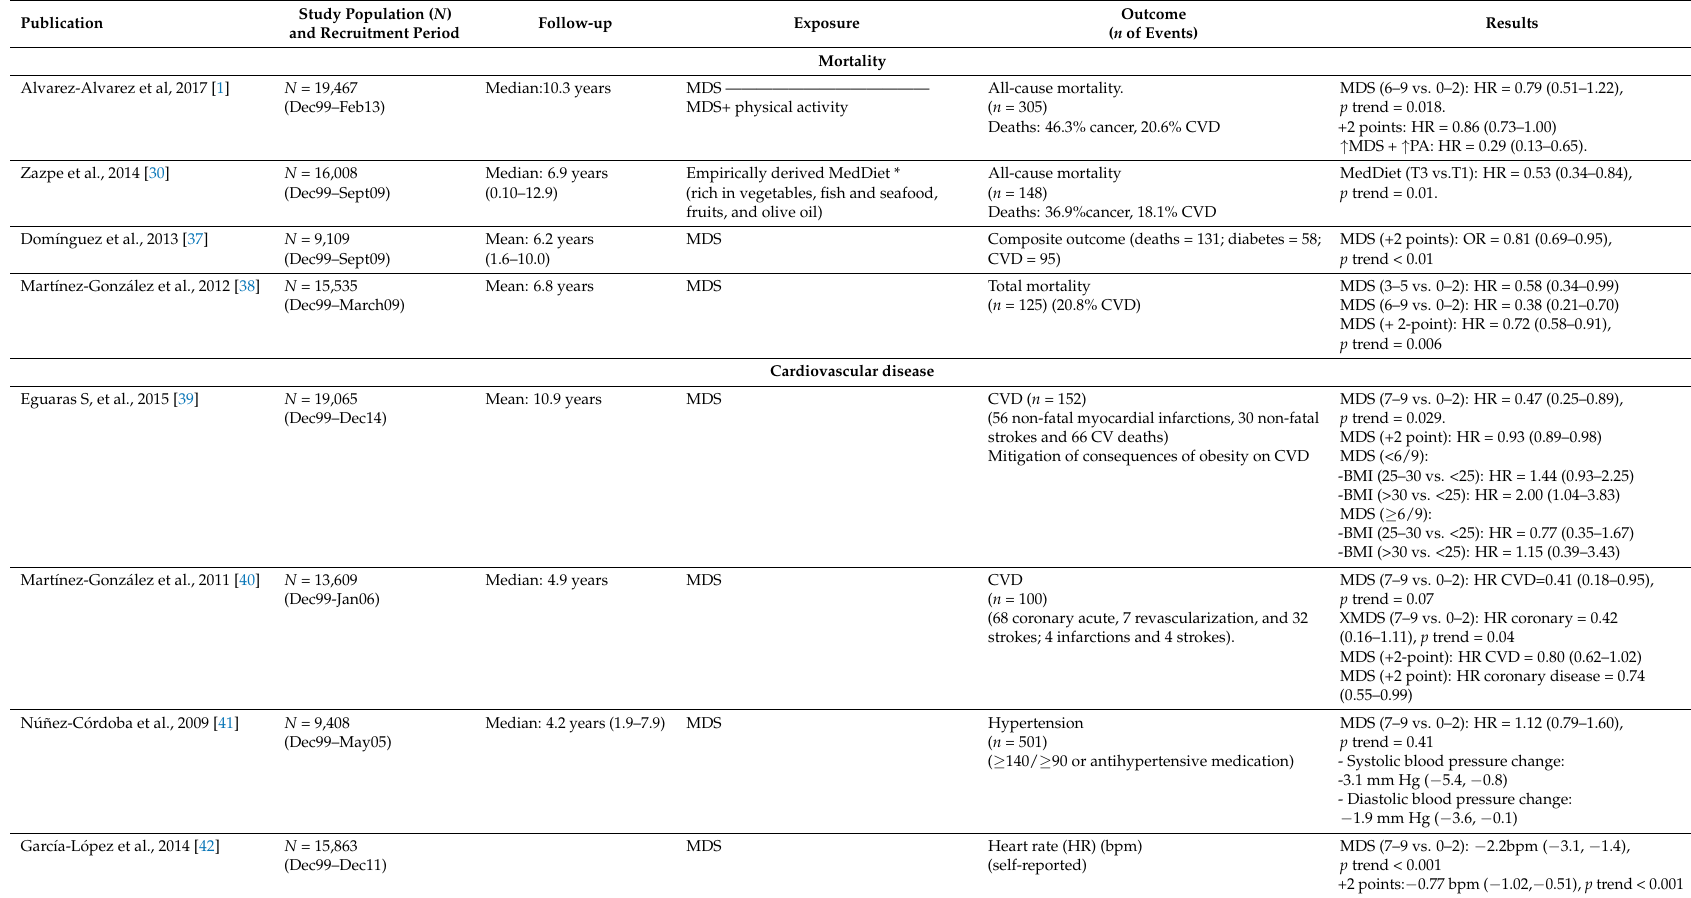
Table 4. Major findings on Mediterranean diet and health